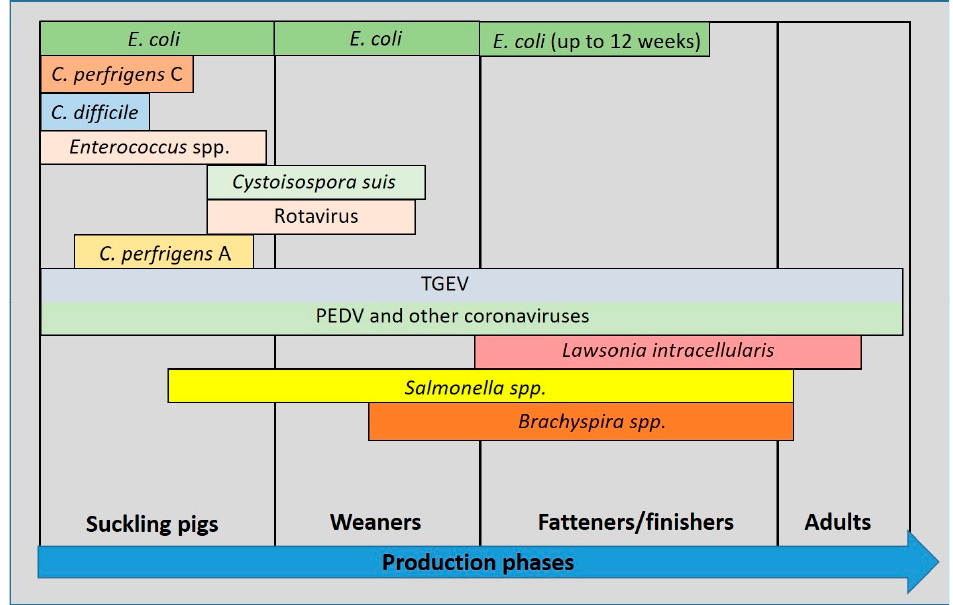
Figure 2 Figure 2. Incidence of pathogens in enteric disease in pigs related to age (modified from S é gales et al., 2013)